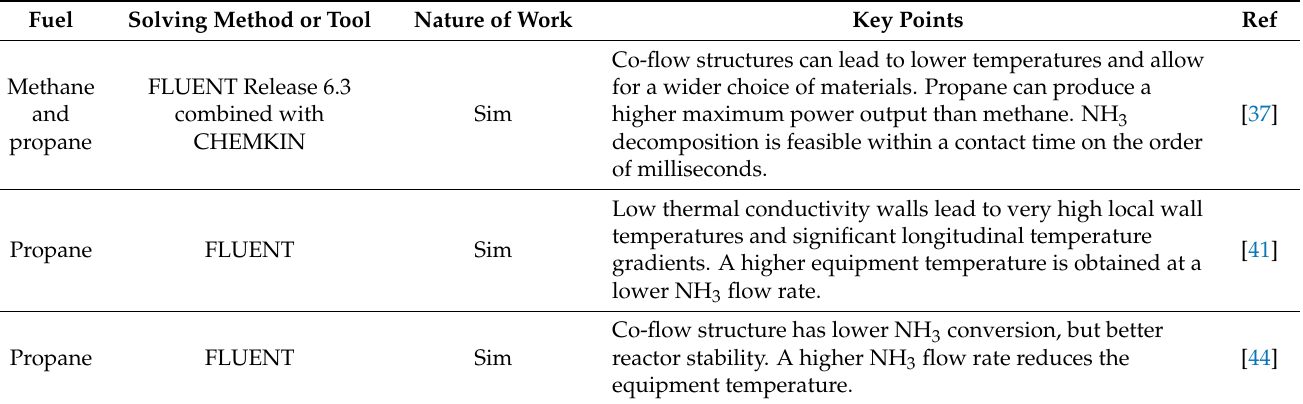
Table 3. Summary of the numerical simulations of coupled combustion and decomposition